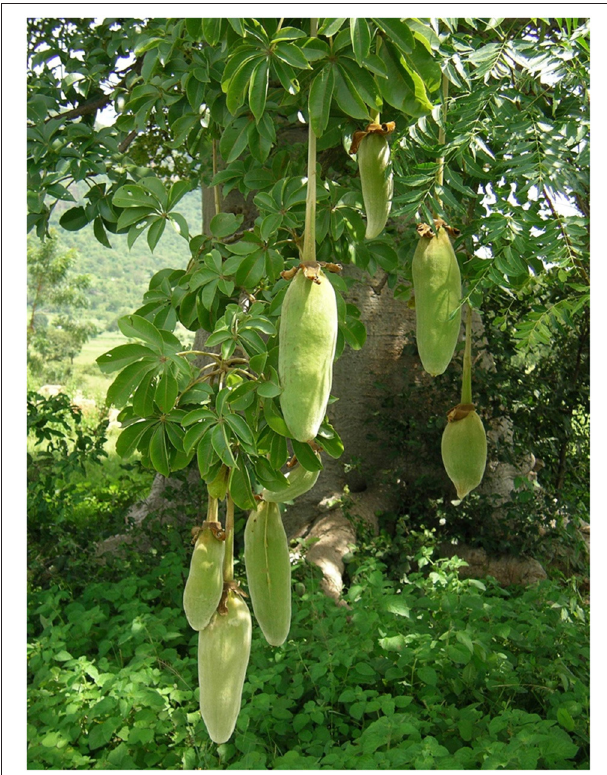
FIGURE 1 | Part of a baobab trunk showing leaves and drooping immature